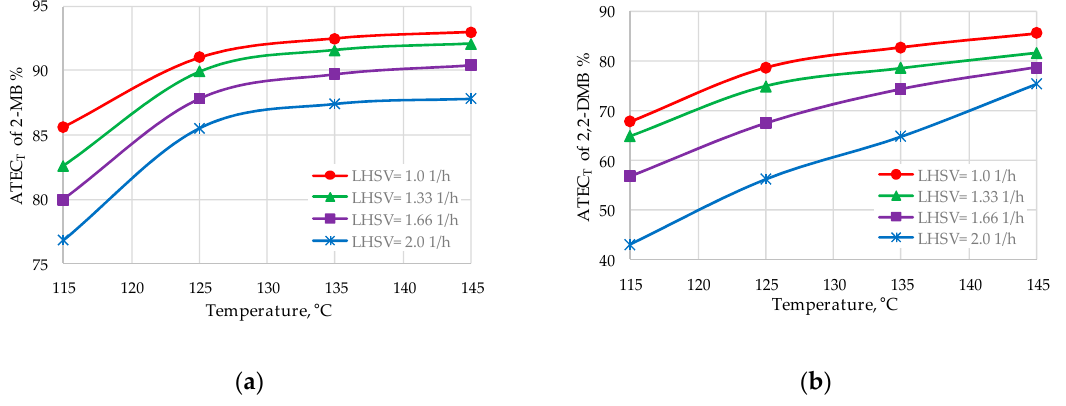
Figure 6. ATEC of 2-MB ( a ) and 2,2-DMB ( b ) as a function of temperature and LHSV (catalyst: Pt/Al 2 O 3 /Cl, feedstock: “A”).